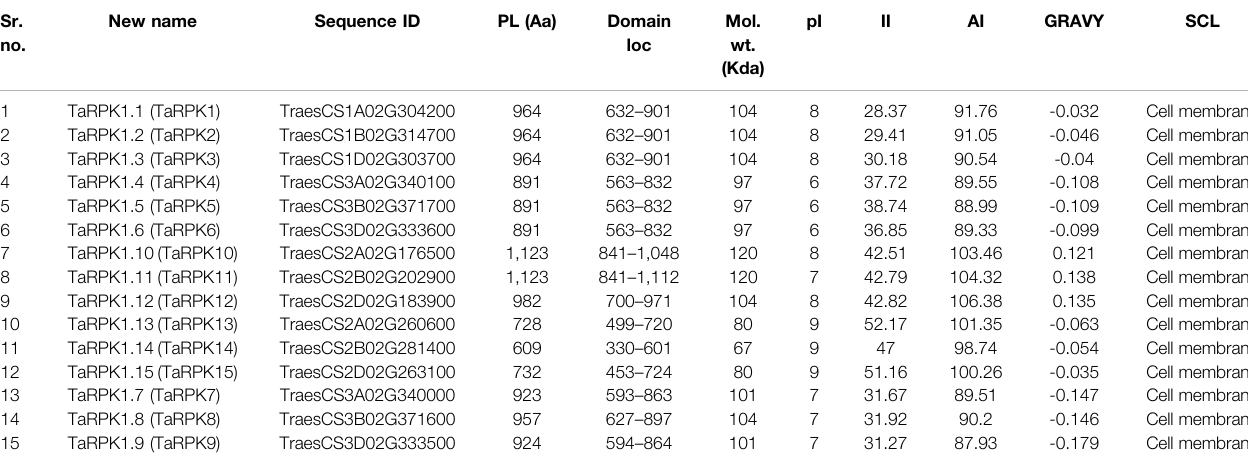
TABLE 2 | In silico -based putative protein information of RPK1 genes identi fi ed in T. aestivum. Sr.